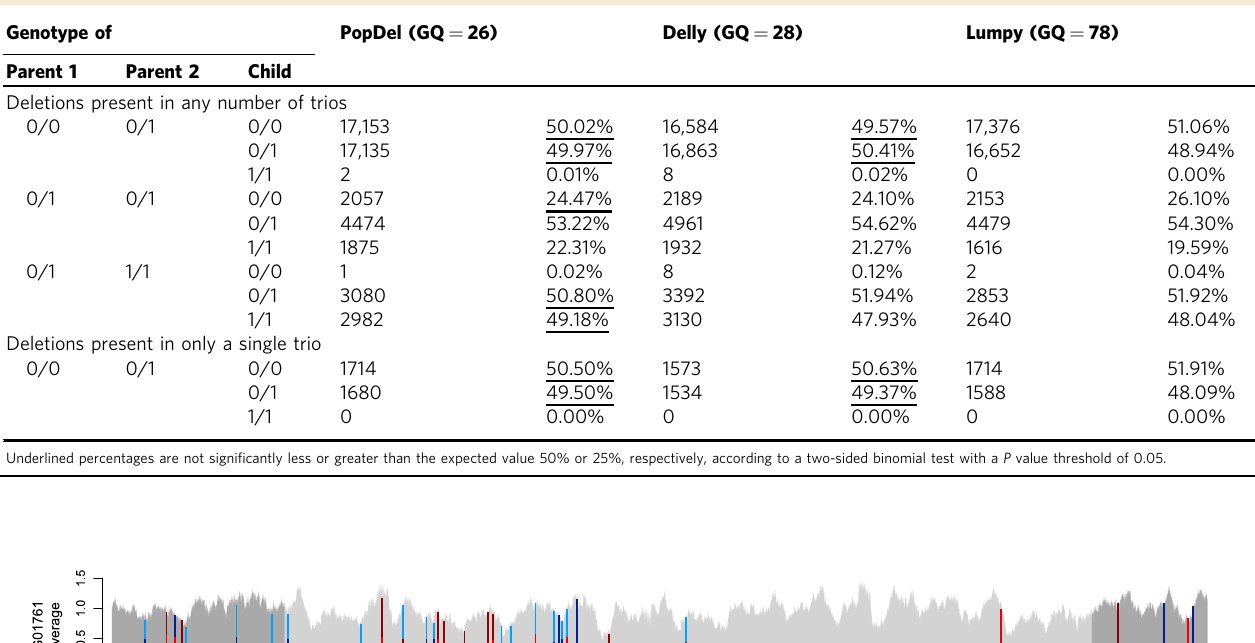
Table 1 Transmission of deletions in the 49 Polaris trios after fi ltering for Hardy – Weinberg equilibrium ( P value 0.01) and genotype quality (GQ) to a Mendelian inheritance error rate just below 0.3%.